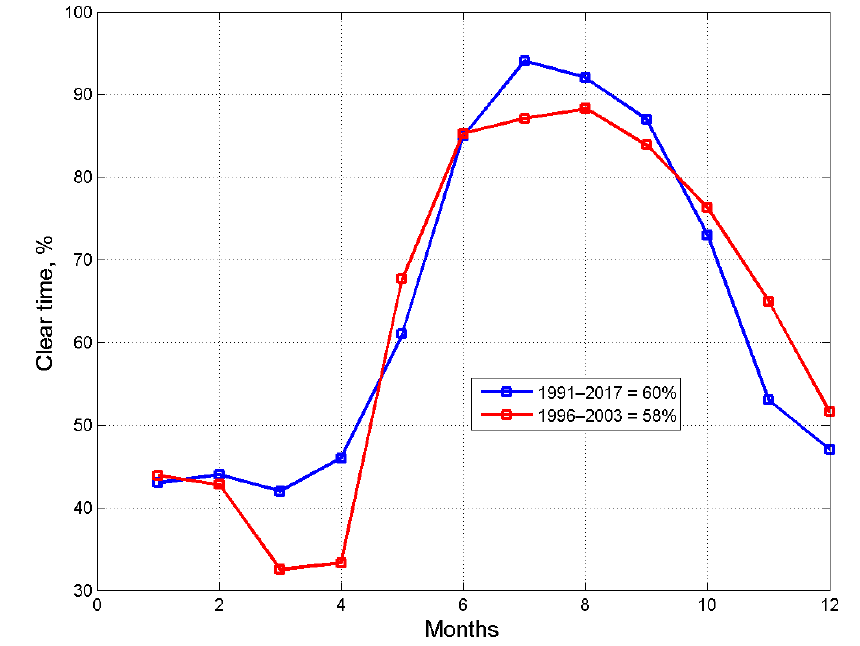
Figure 1. Seasonal distribution of the amount of clear time.